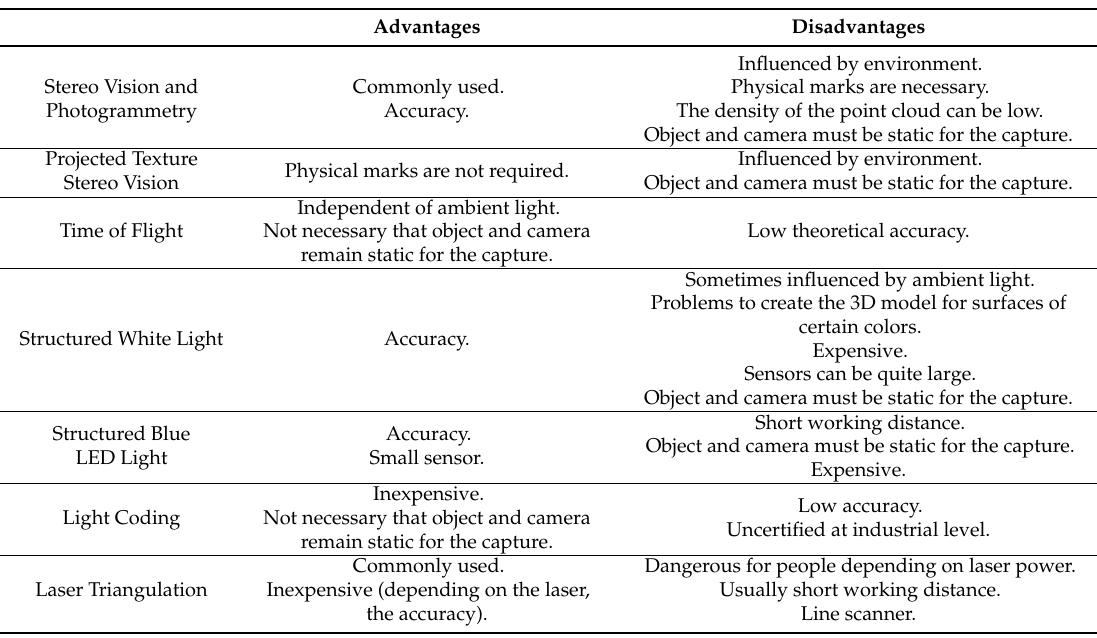
Table 3. Advantages and